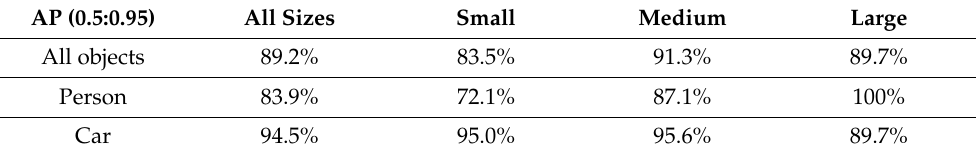
Table 4. Evaluation of the algorithm for detection mapping. Evaluation is performed on labeled SWIR images using COCO_eval library. Small size object presents objects up to 32 × 32 (1024) pixels, medium: from 32 × 32 (1024) to 96 × 96 (9216) pixels, and large objects with size greater than